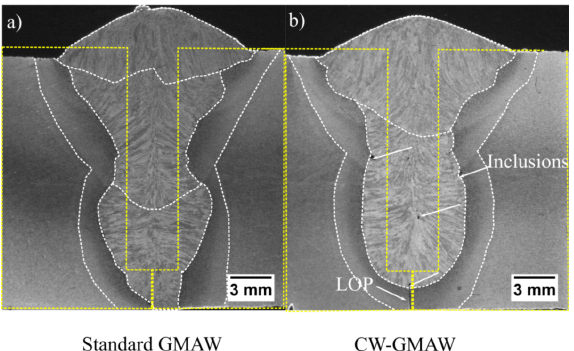
Figure 10. Middle of the bead cross-section showing the final weld morphology: ( a ) standard GMAW; and ( b ) CW-GMAW. The arrows indicate discontinuities such as inclusions and incomplete